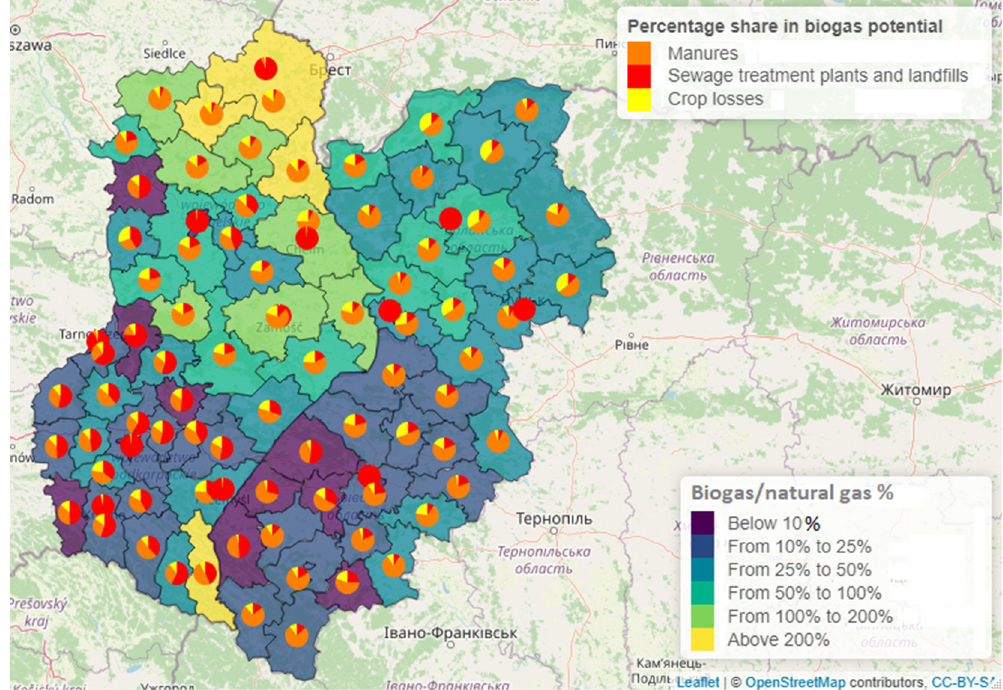
Figure 7. The basic potential of biogas production in relation to the consumption of natural gas with the share of individual sources. Source: Own study. Table 6. The impact of biogas plants at a regional scale. Source: Own